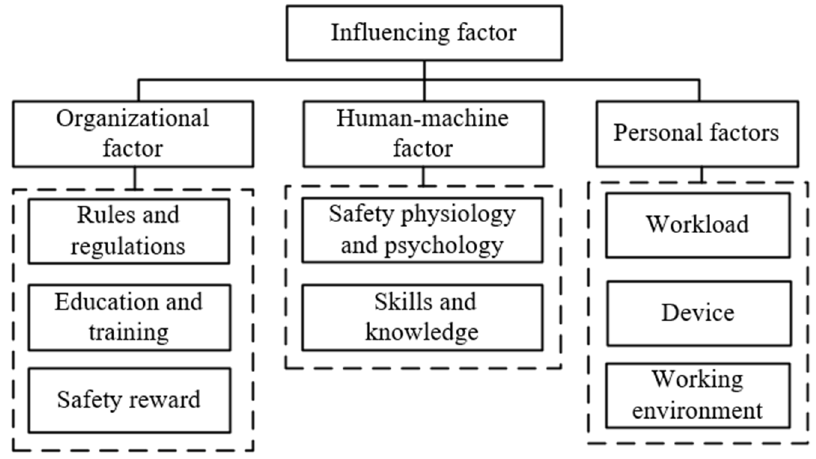
Figure 3. Classification of influencing factors.